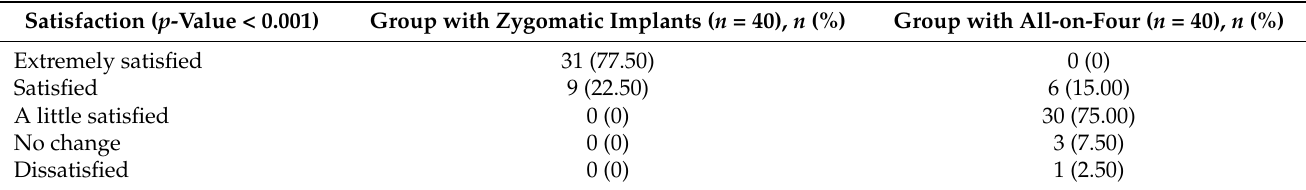
Table 5. Patients’ perception of their implant-supported prostheses (Pearson’s χ 2 test). Satisfaction ( p -Value < 0.001)